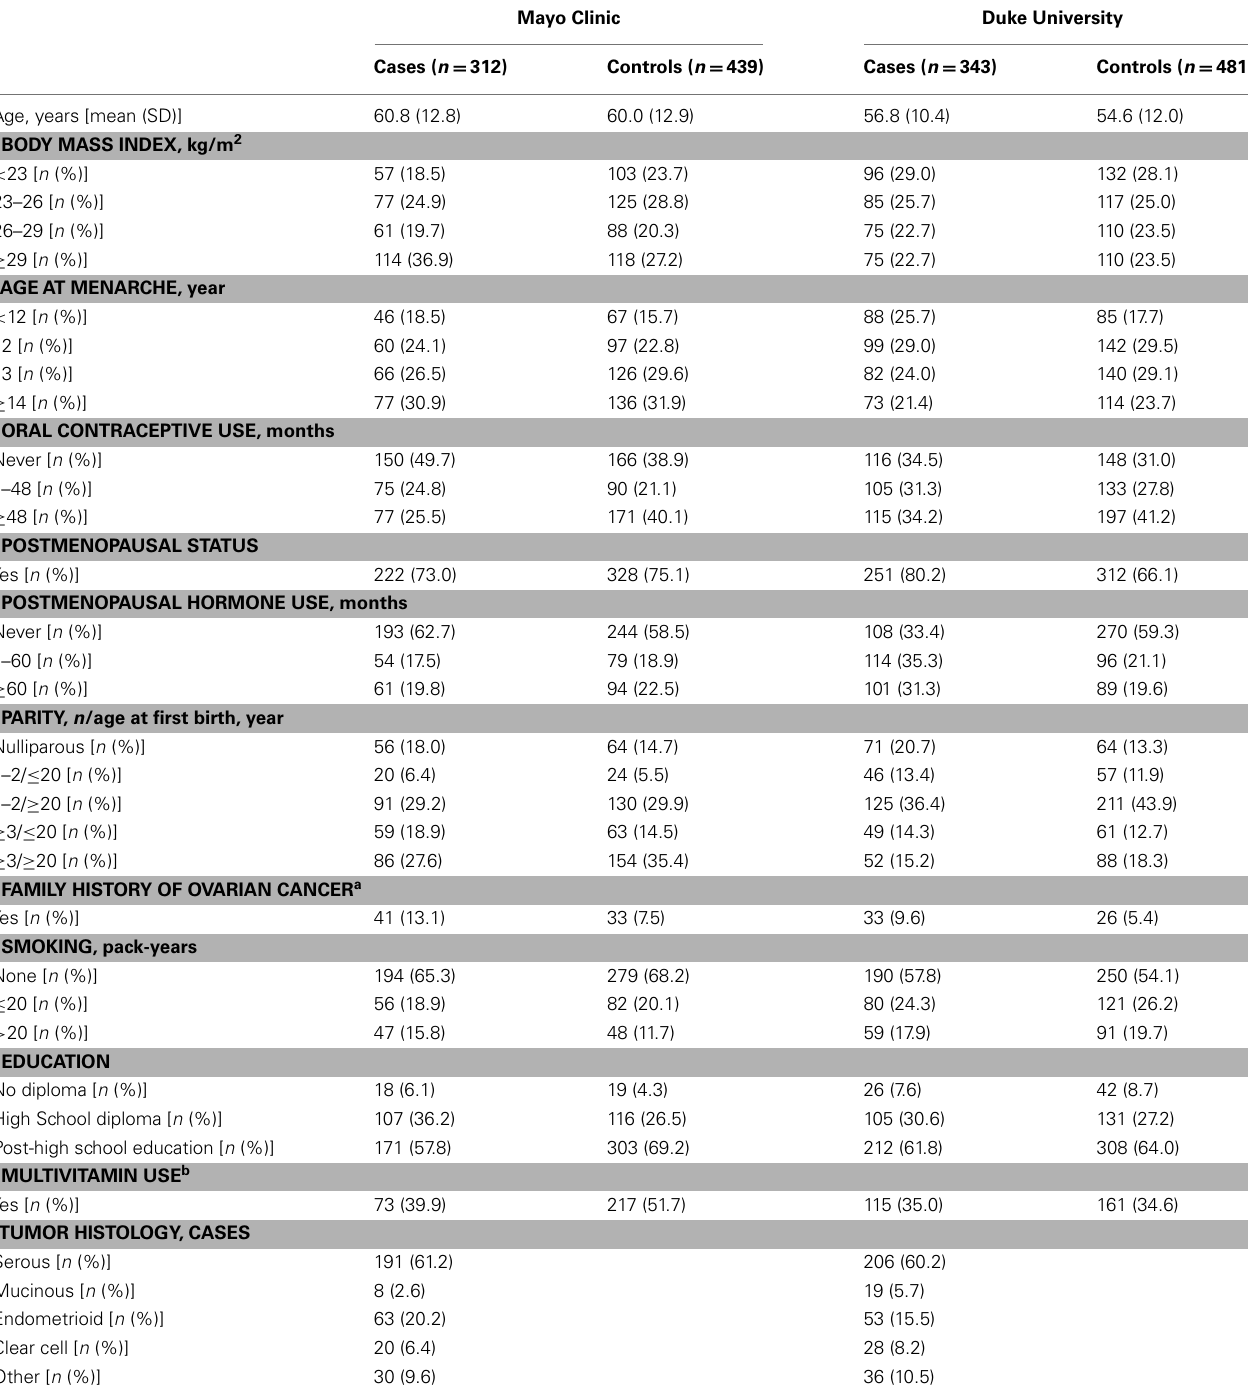
TableA2 | Characteristics of 1,575 Caucasian subjects (Phase 1), Mayo Clinic, and Duke